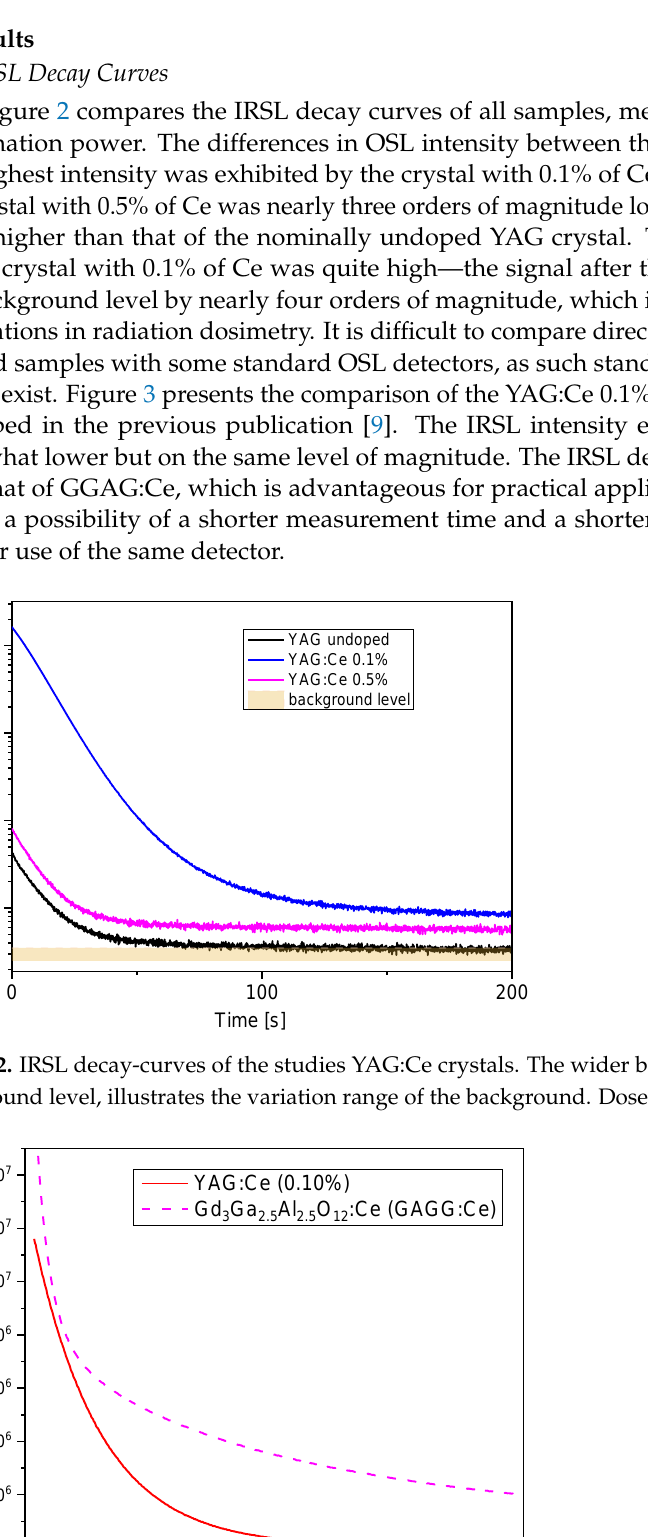
Figure 1. The pictures of the studied YAG crystals, with the data on thickness and mass of the sam- ples. The distance between lines in the background is 3 mm.